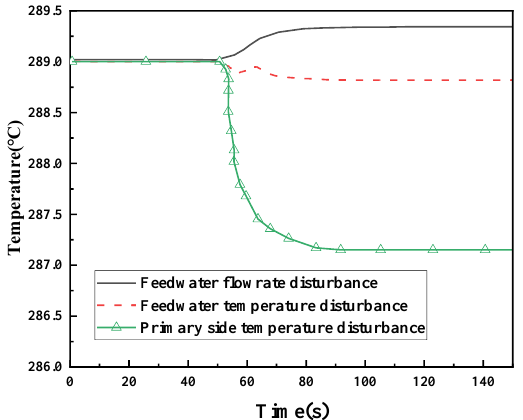
Figure A1. LBE outlet temperature variation under different step disturbances. Figure A2 shows the change in primary side outlet temperature under different disturbances in Ref. [23]. The disturbance of feedwater flowrate is step change − 2.3%, and the disturbance of feedwater temperature and primary side temperature is step change − 5 °C. Comparing Figures A1 and A2, it can be seen that the model in this work is consistent with the RELAP5 model in Ref. [23]. The effect of feedwater flowrate disturbance in the reference is less than our model, because the feedwater flowrate disturbance introduced in the reference is only 2.3% and that in this paper is 5%.